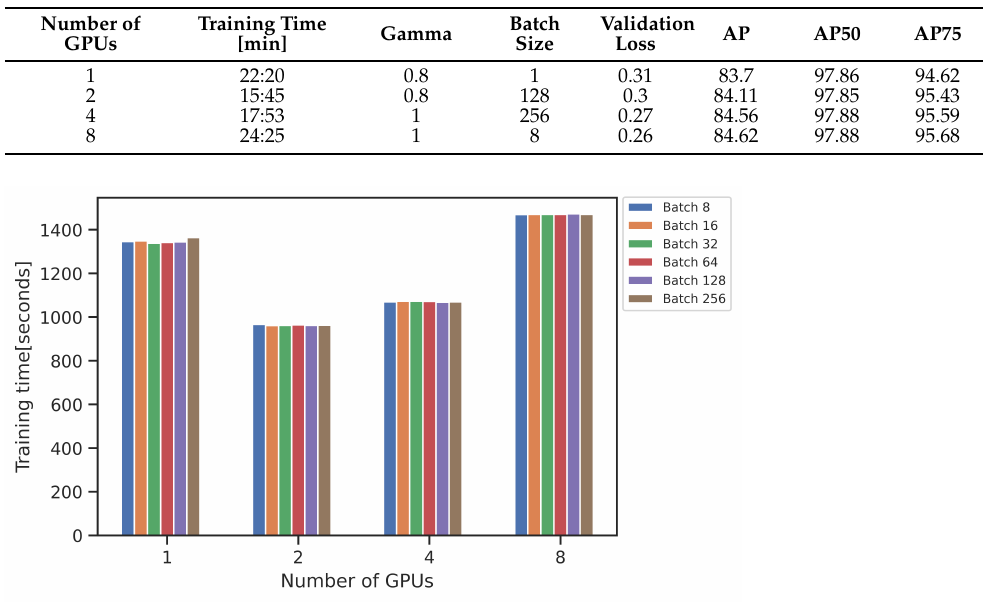
Table 2. Object detection: hyperparameter optimization results for faster_rcnn_R_101_FPN_3x, 1000 epochs, for different values of gamma and batch sizes.